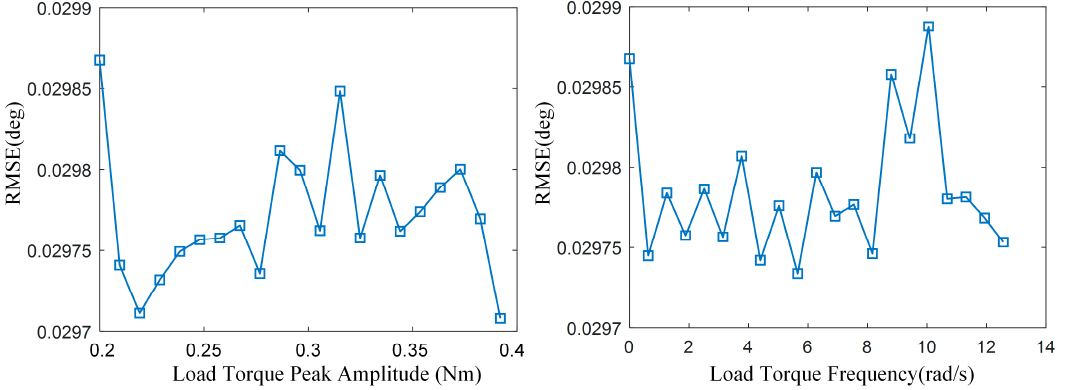
Figure 16. Toolface tracking errors in the presence of load torque.